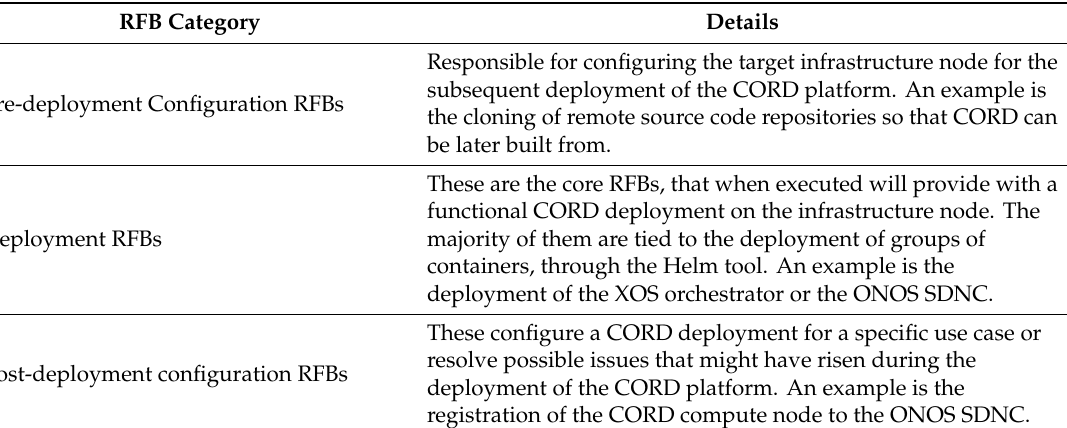
Table 3. RFB Categories.